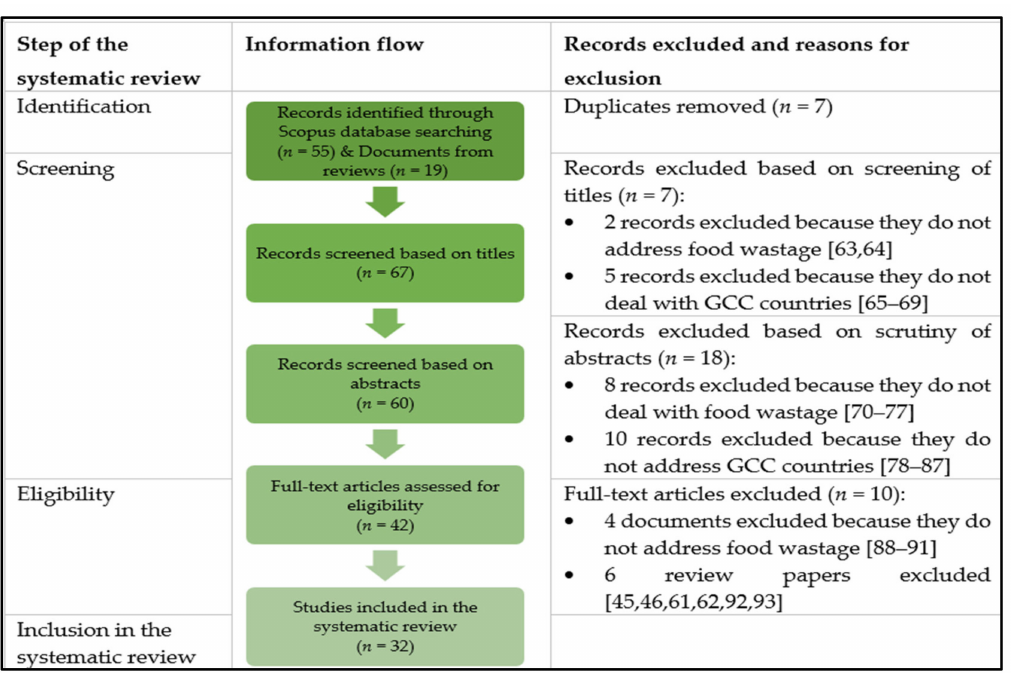
Figure 1. Process of the search and selection of documents, n = 7 [63–69], n = 18 [70–87], n = 10 [45,46,61,62,88–93].